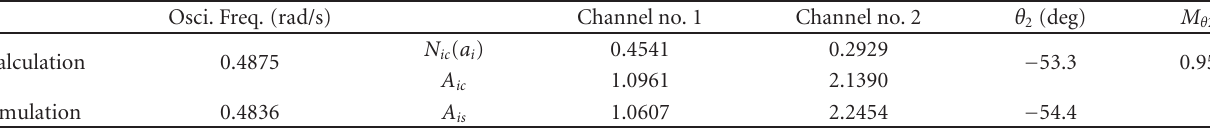
Table 3: Calculated and simulated results of Example 1.